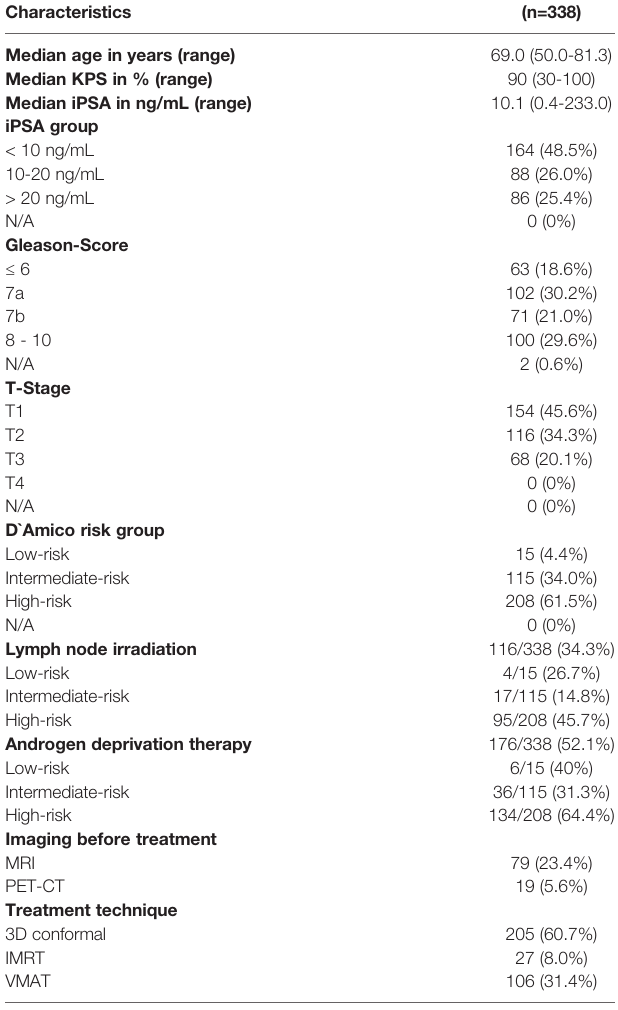
TABLE 1 | Patient and treatment characteristics.